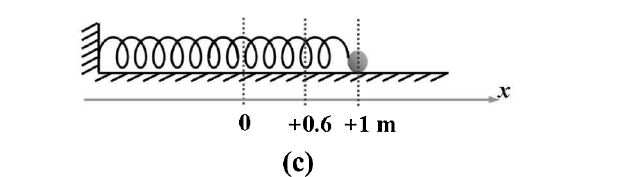
FIG. 1 (color online). A sequence example: (a) and (b) are two conceptually based multiple-choice questions; (c) is an open- ended problem that synthesizes broadly separated topics in teaching materials. We deliberately used the phrase of ‘‘mechanical energy’’ in (a) and (b) to distinguish it from ‘‘energy’’ of a system, as the former is conserved only in the absence of dissipative forces while the latter is always conserved